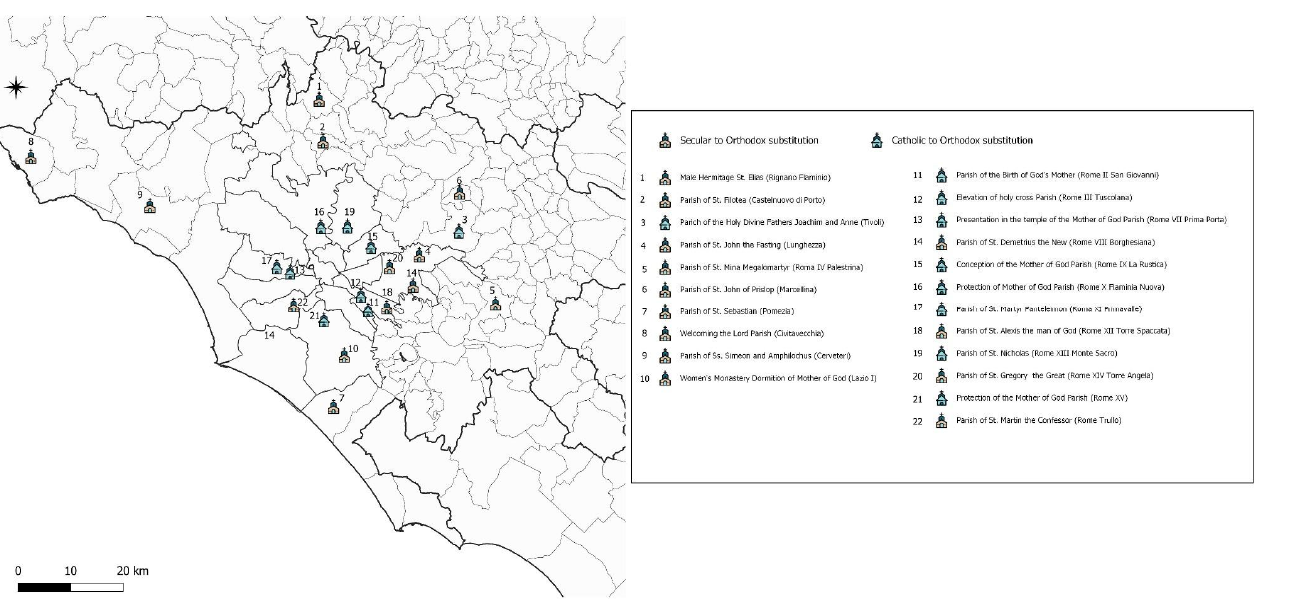
Figure 2. Classification of architectural typologies on the basis of (1) secular to Orthodox substitution; (2) Catholic to Orthodox substitution in the Metropolitan City of Rome. Source: Cartographic elaboration by SO on data of Cozma and Giorda (2020).